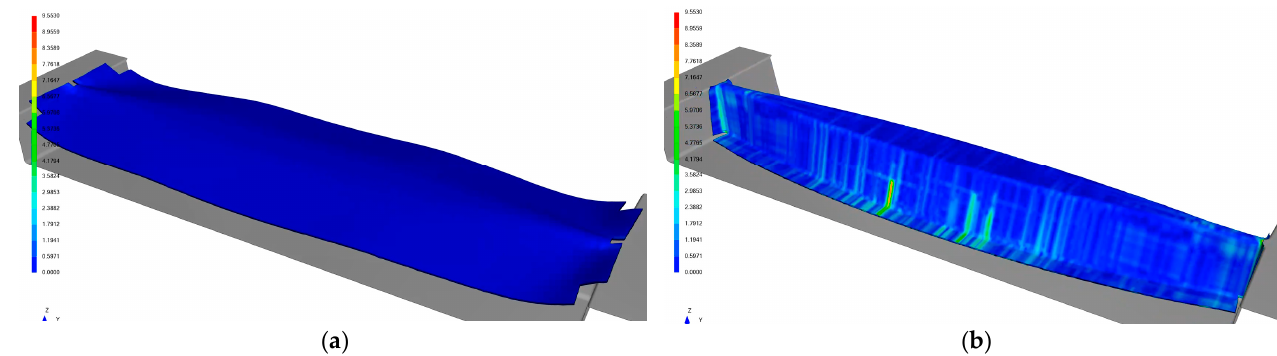
Figure 5. Contour maps of shear deformation at the beginning of forming (a) and in the final shape of stamping (b).